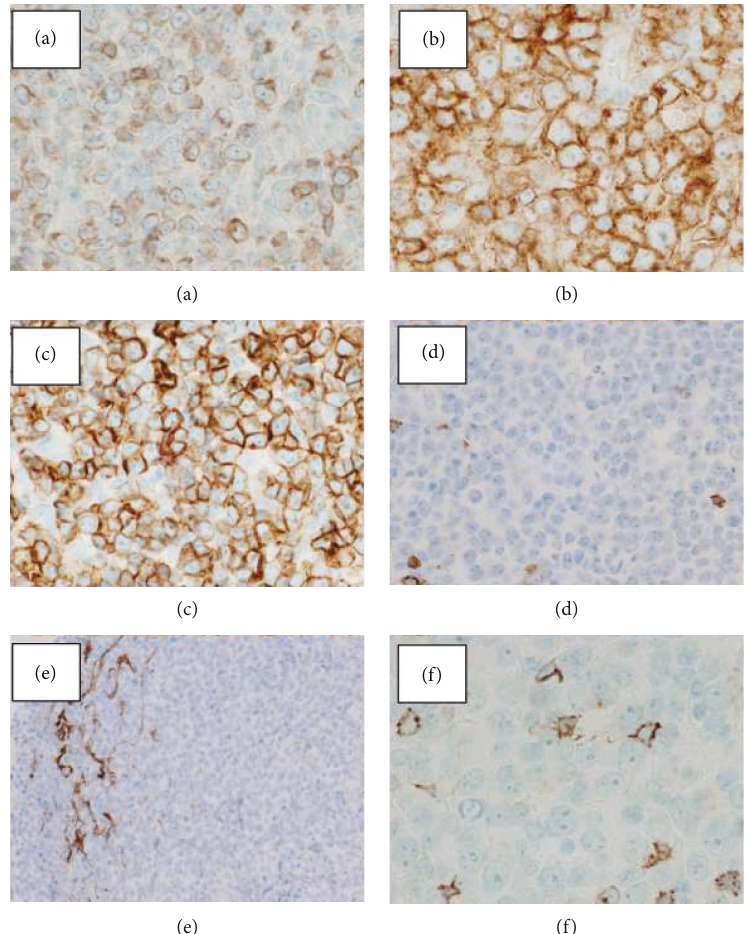
Figure 4: Tumor cells were CD3+ (a), CD4+ (b), CD5+ (c), CD8- (d), CD 20- (e), and CD21- (f) on